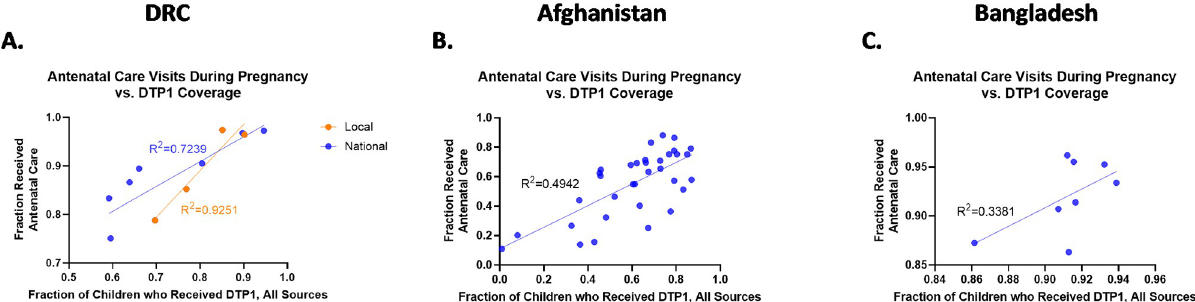
Fig 2. Linear regression between DTP1 coverage and antenatal care in DRC (A), Afghanistan (B), and Bangladesh (C). Local data points in DRC (A) refer to subnational regions in DRC where emergency conditions are more acute, specifically Kasai-Occidental, Kasai-oriental, Nord-kivu and Sud- kivu, while the national set encompasses all subnational data points. The degree of linear association was strongest in these specific regions in the DRC compared to the country as a whole (R 2 = 0.93 vs. R 2 = 0.72). Meanwhile Afghanistan (B) and Bangladesh (C) still saw weak linear associations between DTP1 coverage and antenatal care visits (R 2 = 0.49, and R 2 = 0.34 respectively).